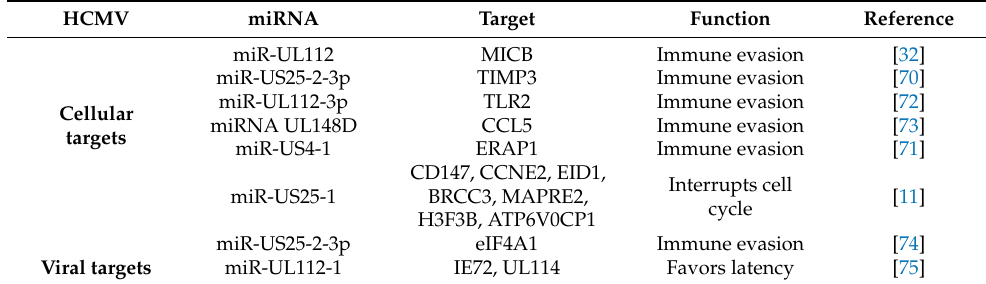
Table 3. Potential cellular and viral targets of HCMV miRNAs 3